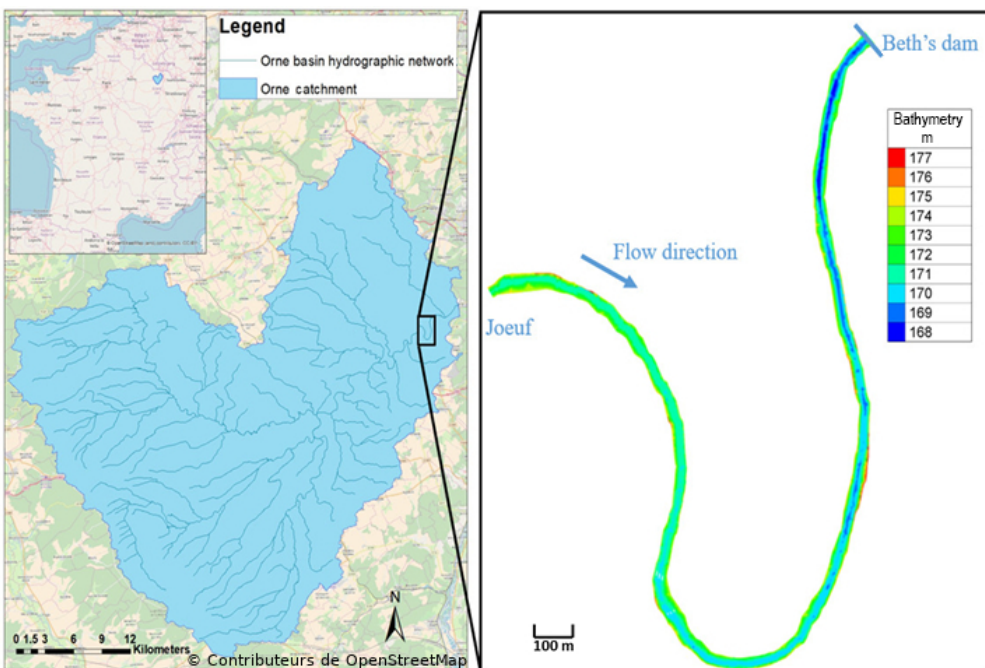
Figure 1. Study area and model domain (4km long control section of the Orne river). © OpenStreetMap contributors 2019. Distributed under